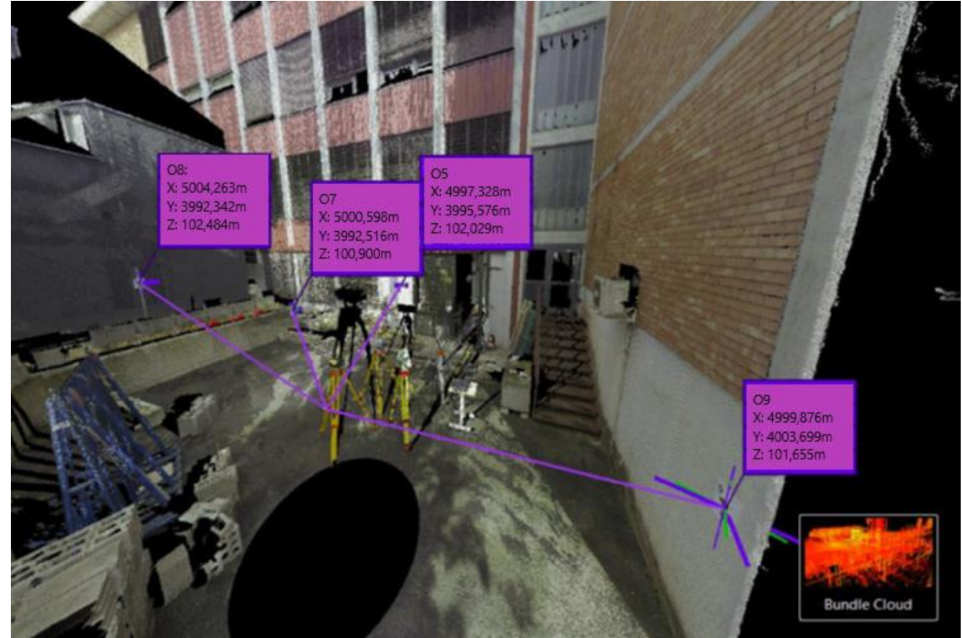
Figure 6. Identification of support points of the combined point cloud required for transformation into the selected coordinate